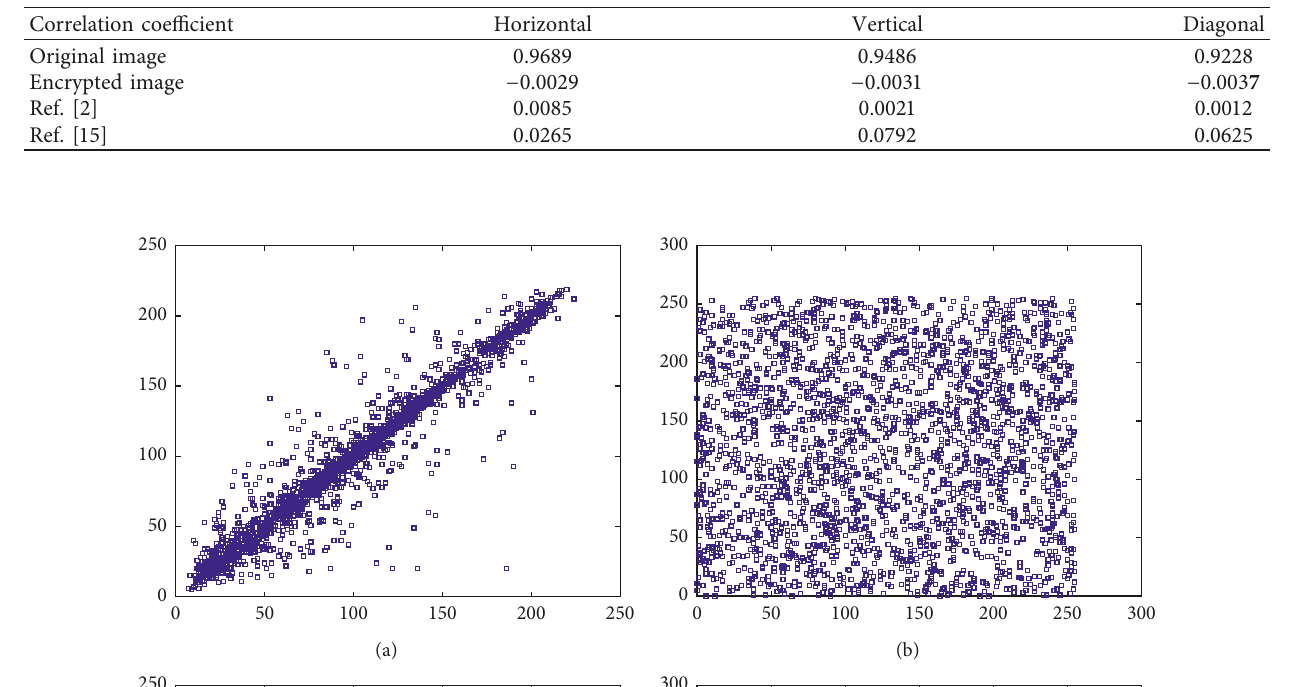
Table 4: The correlation of the adjacent pixels for original and encrypted